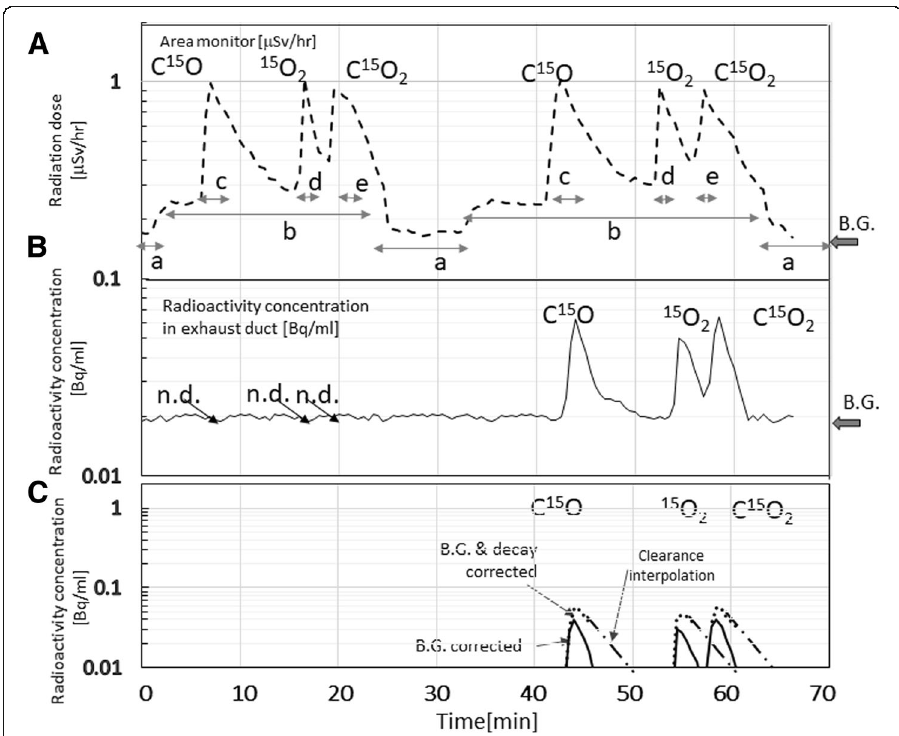
Fig. 10 Example of time-activity curves of the gamma-ray monitor detector placed in the PET room ( a ), the radioactivity concentration of the air in the exhaust duct carried from the PET scanner room ( b ), and background- and decay-corrected radioactivity curves in the exhaust duct ( c ). Data were observed during a series of PET examinations involving C 15 O, 15 O 2 , and C 15 O 2 inhalation on each of two patients. Characters “ a ” and “ b ” corresponded to a period when the cyclotron was accelerating a deuteron beam to a target, in which the radioactive gas was not circulated to the PET room during period “ a, ” but it was circulated to the PET room during period “ b. ” The three other characters “ c, ” “ d, ” and “ e ” corresponded to the periods of supplying C 15 O, 15 O 2 , and C 15 O 2 gases to the patient ’ s facemask, respectively. Leakage of gaseous radioactivity was not detected (n.d.) during the first examination, but was significant in the second examination as shown in ( b